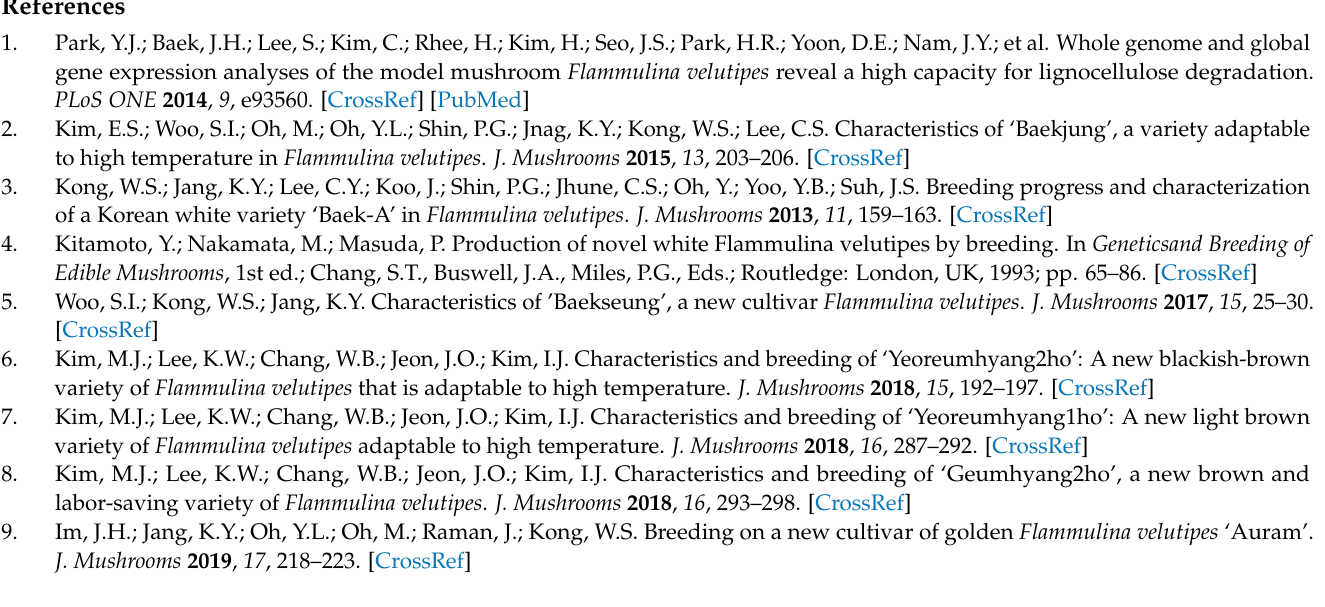
F. velutipes ASI4169 (white). Figure S2: Amplification refractory mutation system (ARMS) PCR of Fvpal1 in monospores from Flammulina velutipes ASI4175 (heterozygote, non-white) (a) and w1-8 (homozygote, white) (b) strains. Asterisks indicate F. velutipes monospores without mutation in the Fvpal1 gene. Figure S3: Alignments of phenylalanine ammonia-lyase 2 ( Fvpal2 ) genes of Flammulina velutipes strains. (a) cDNA sequence and (b) amino acid sequence. F. velutipes KACC42870 (non-white), F. velutipes ASI4208 (non-white), F. velutipes ASI4049 (non-white), F. velutipes ASI4057 (non-white), F. velutipes ASI4166 (white), F. velutipes ASI4167 (white), and F. velutipes ASI4169 (white). Table S1: White-color-specific variations identified in Flammulina velutipes strains. Table S2: Predicted gene models of Flammulina velutipes